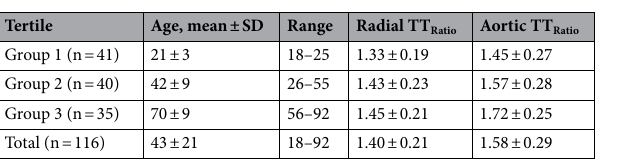
Table 3. Age-related changes in transit time ratio.